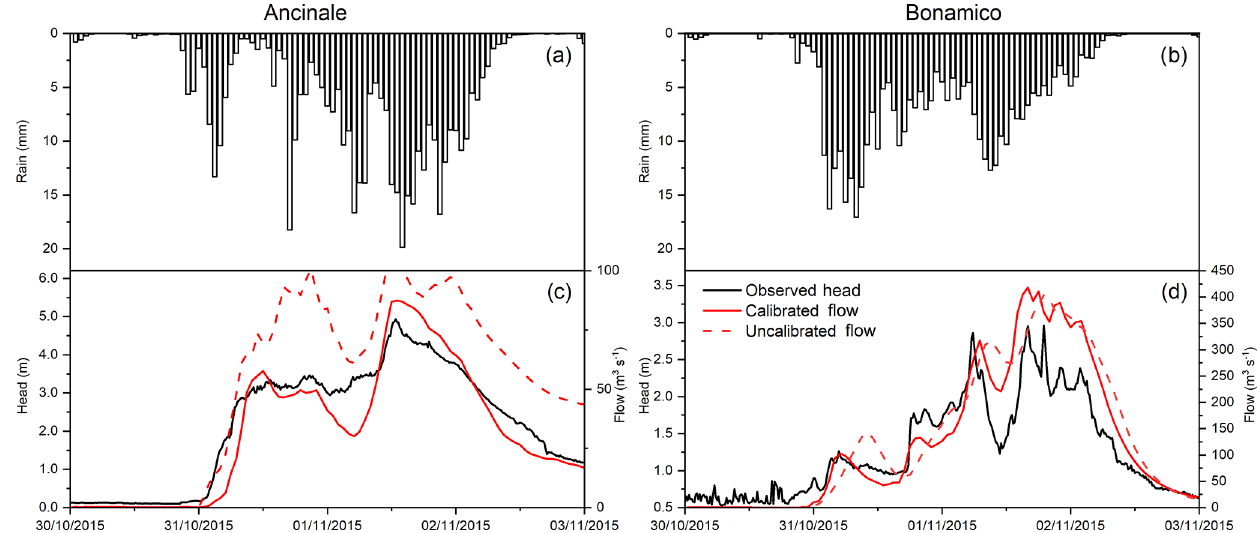
Figure 4. (a) Observed hourly rainfall (mm) averaged over the Ancinale River catchment; (b) as in panel (a) , but for the Bonamico Creek catchment. (c) A comparison between observed hydrometric levels (m) with respect to uncalibrated and calibrated simulated flow (m 3 s − 1 ) over the Ancinale River catchment; (d) as in panel (c) , but for the Bonamico Creek catchment.